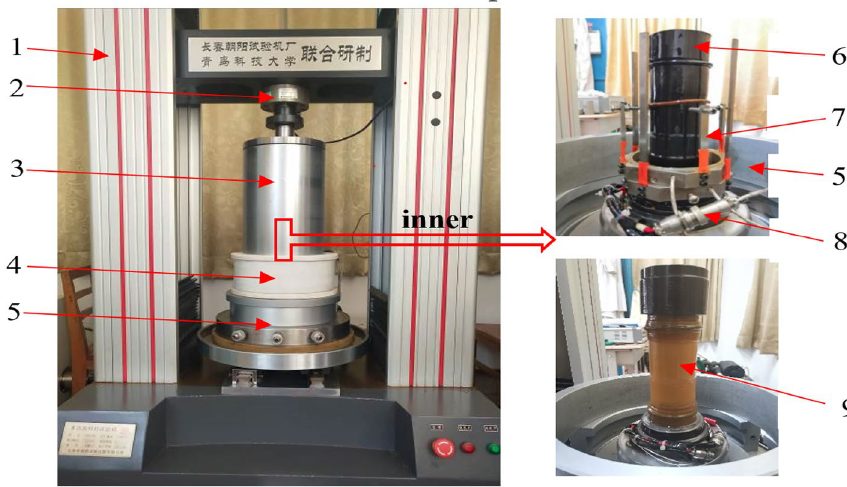
Figure 1. Triaxial compression test: 1—testing machine frame, 2—pressure sensor, 3—confining pressure chamber, 4—electromagnetic heating coil, 5—surrounding block, 6—heat shrinkable tube, 7—Radial displacement sensor, 8—temperature sensor, 9—rubber